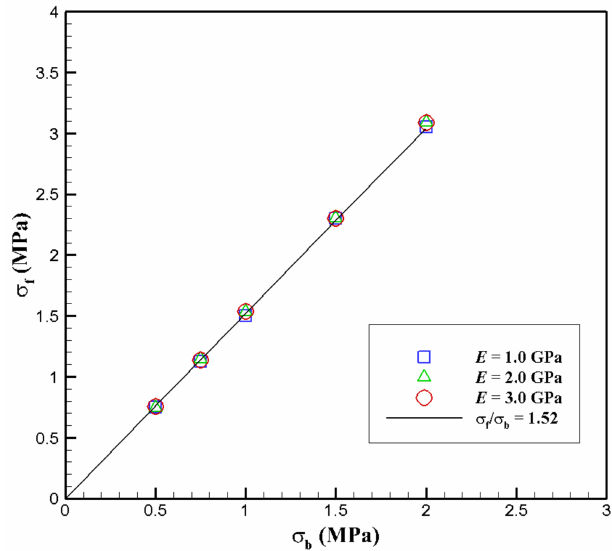
Figure 8. Effect of bond strength on the flexural